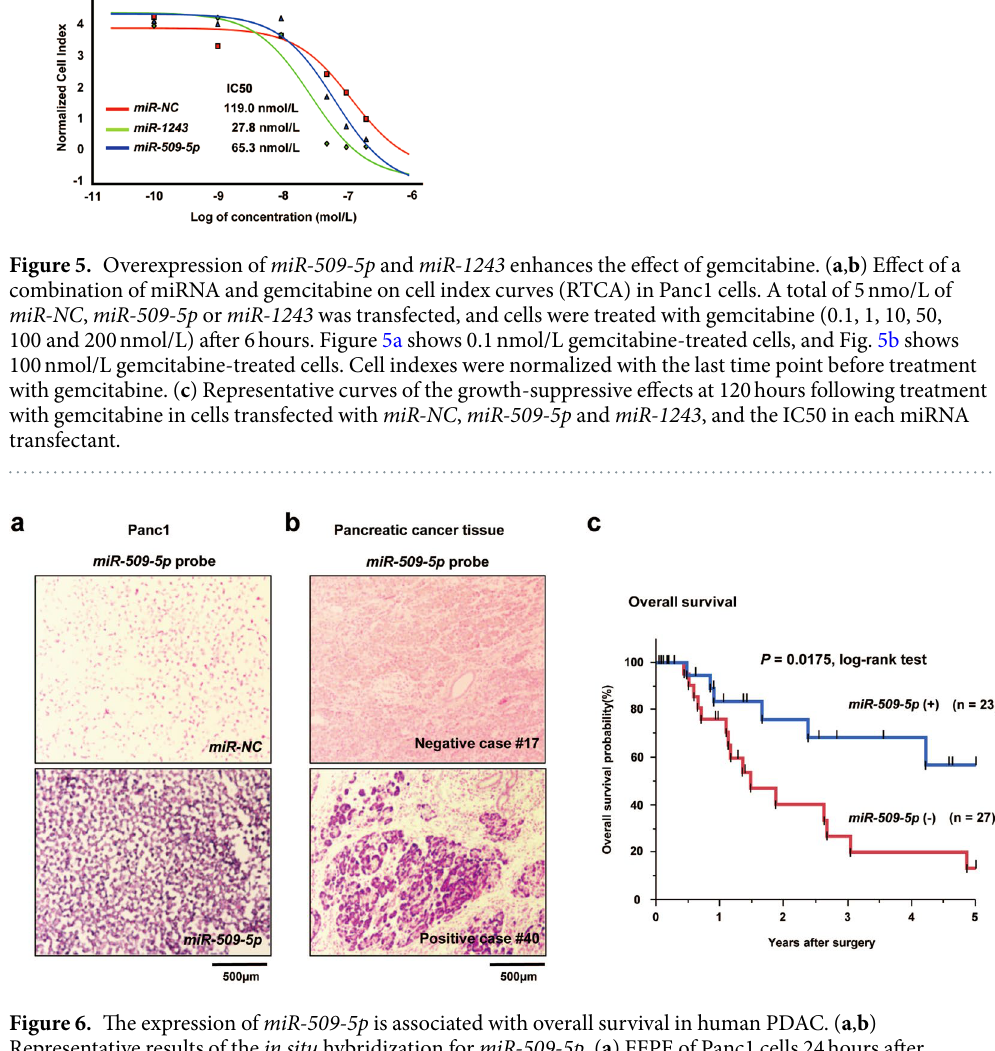
miR-509-5p and the lymphatic invasion category in the tumor-lymph node-metastases (TNM) classification were significantly associated with overall survival. In the multivariate analysis using a stepwise Cox regression proce- dure, the expression of miR-509-5p based on the TNM classification was identified as an independently selected